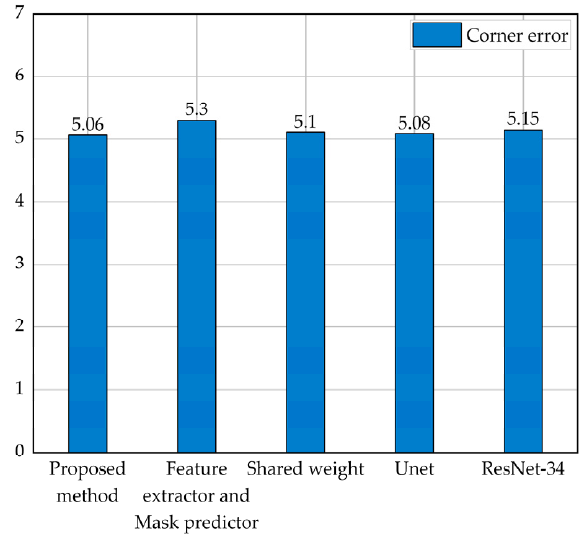
( f ) Figure 12. Comparison of feature map of feature extractor and mask predictor [15] and shallow